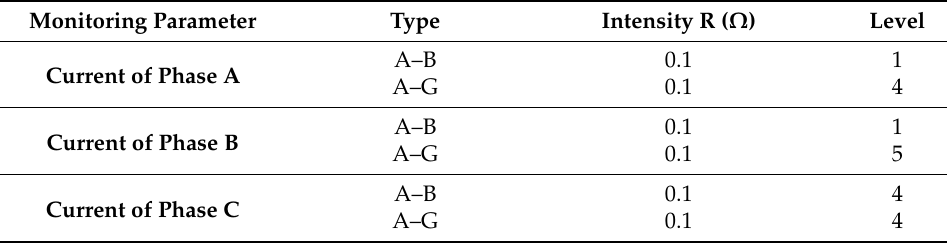
Table 7. Operation with fault at 1.4–1.7 s for step load torque and W–N = 60 Eb/No.